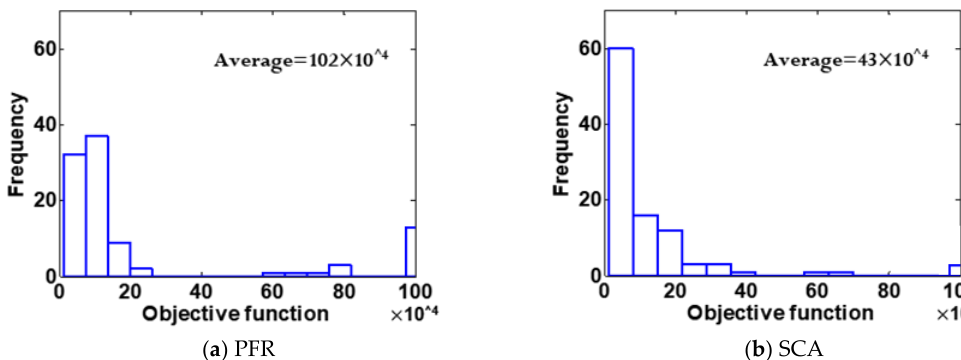
Figure 11. Gas and water well production rates of initial ensemble and updated ensembles using PFR and SCA.